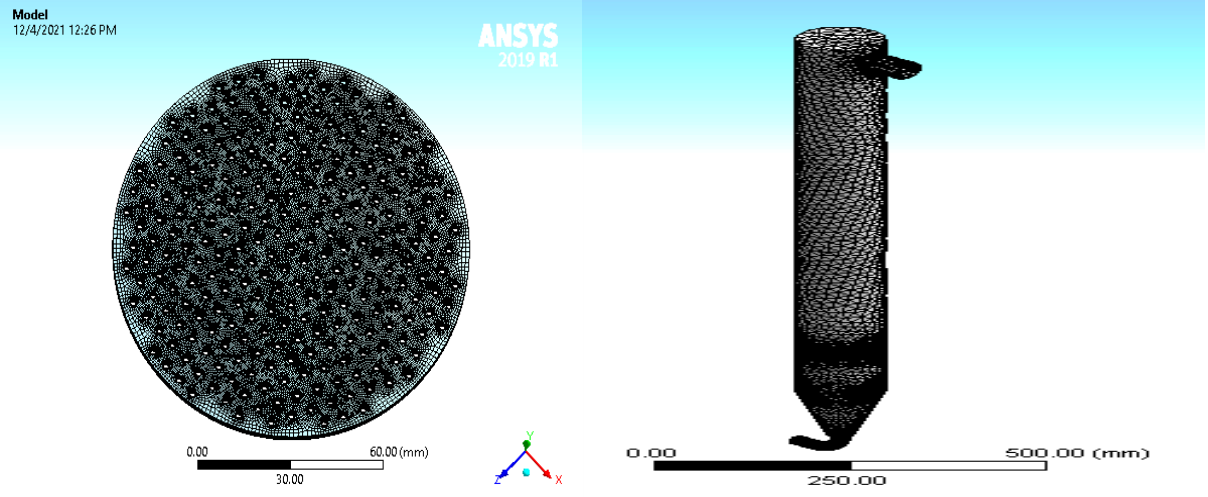
Figure 2. Two-dimensional computational geometry of a fluidized bed.